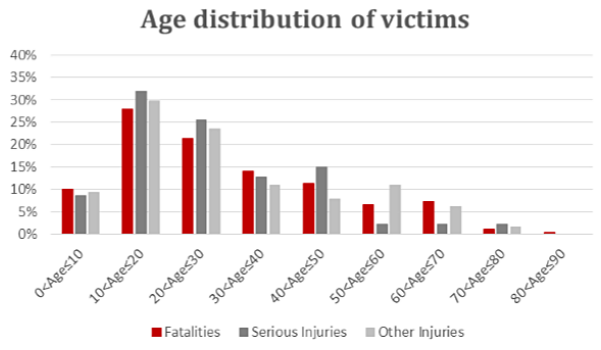
Figure 11. Age distribution of lightning victims by fatalities, seri- ous injuries, and other injuries (January 1930 to June 2014).